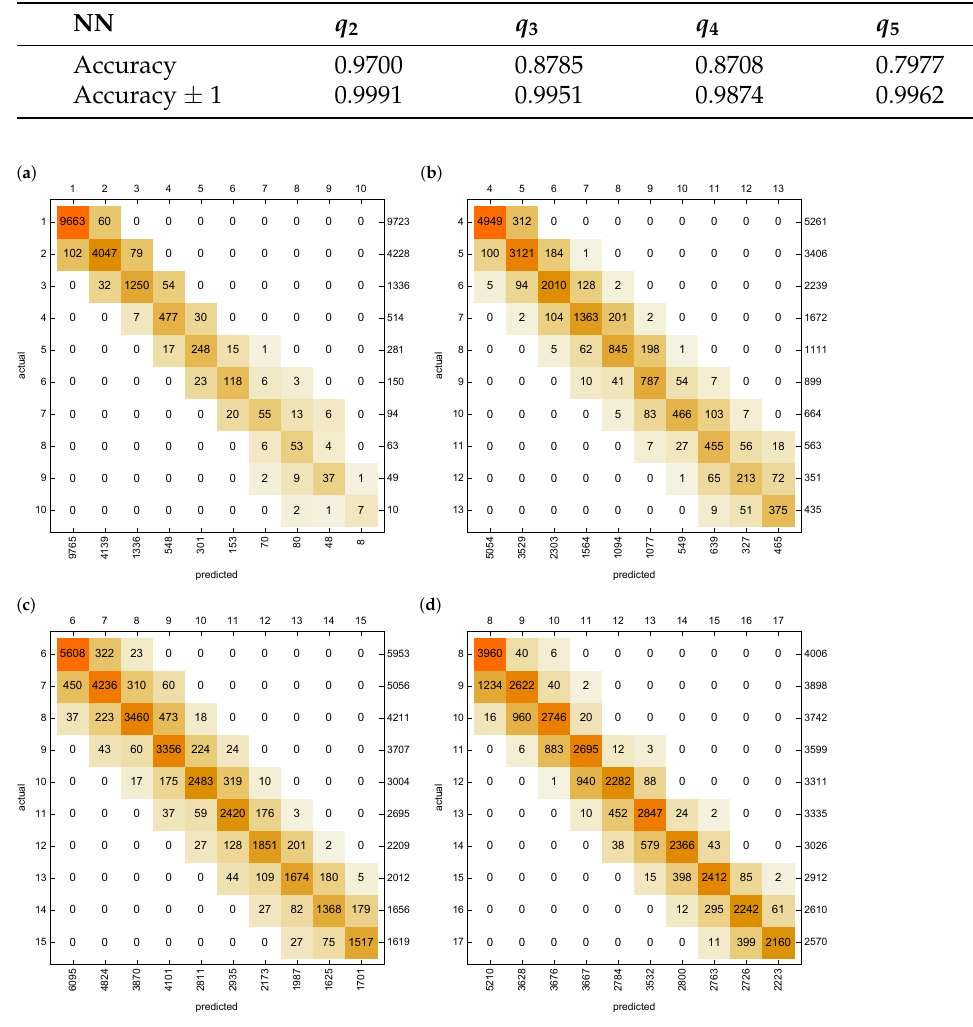
Figure 5. Confusion matrices ( a – d ) for prediction of q 2 , q 3 , q 4 and q 5 using